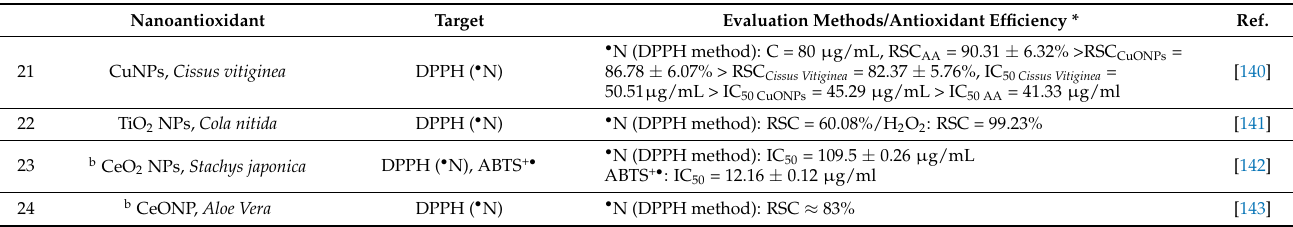
Figure 16. Schematic representation of an effective hybrid monodispersed nanoantioxidant p(TA)- Si NPs composite of tannic acid and silica nanoparticles via a modified Stöber method and one-pot synthesis. Reprinted (adapted) with permission from [27].